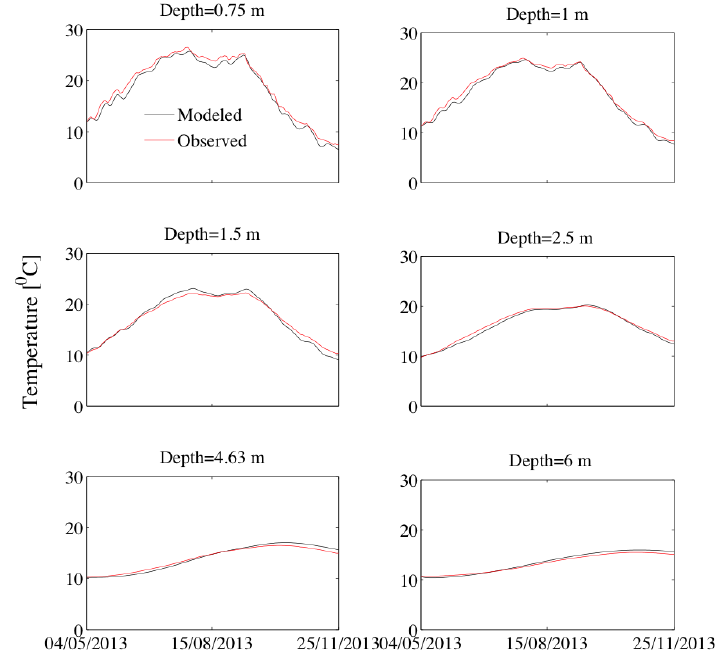
Figure 6. Comparison of the measured and modeled temperatures at depths of 0.75, 1, 1.5, 2.5, 4.63 and 6m during the simulation period. The black line denotes the modeling results obtained from the coupled hydrological-thermal-geophysical inversion. The red line represents the measurements.